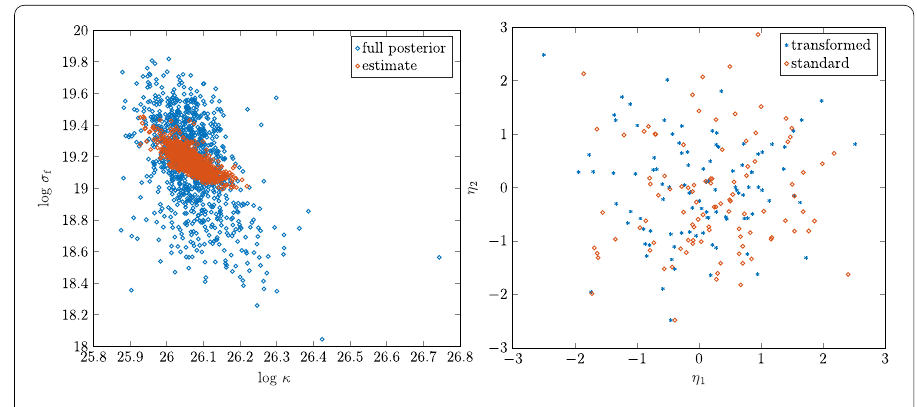
Fig. 12 Left: Scatter plot between the log of estimated macro-scale bulk modulus κ [MPa] and limit stress σ f [MPa] w.r.t. to the full posterior measure (aleatoric plus epistemic uncertainty), and its epistemic mean (only aleatoric uncertainty, here denoted as “estimate”). Right: Comparison of 100 samples of mapped Gaussian random variables from the estimated macro-parameters and independent standard Gaussians